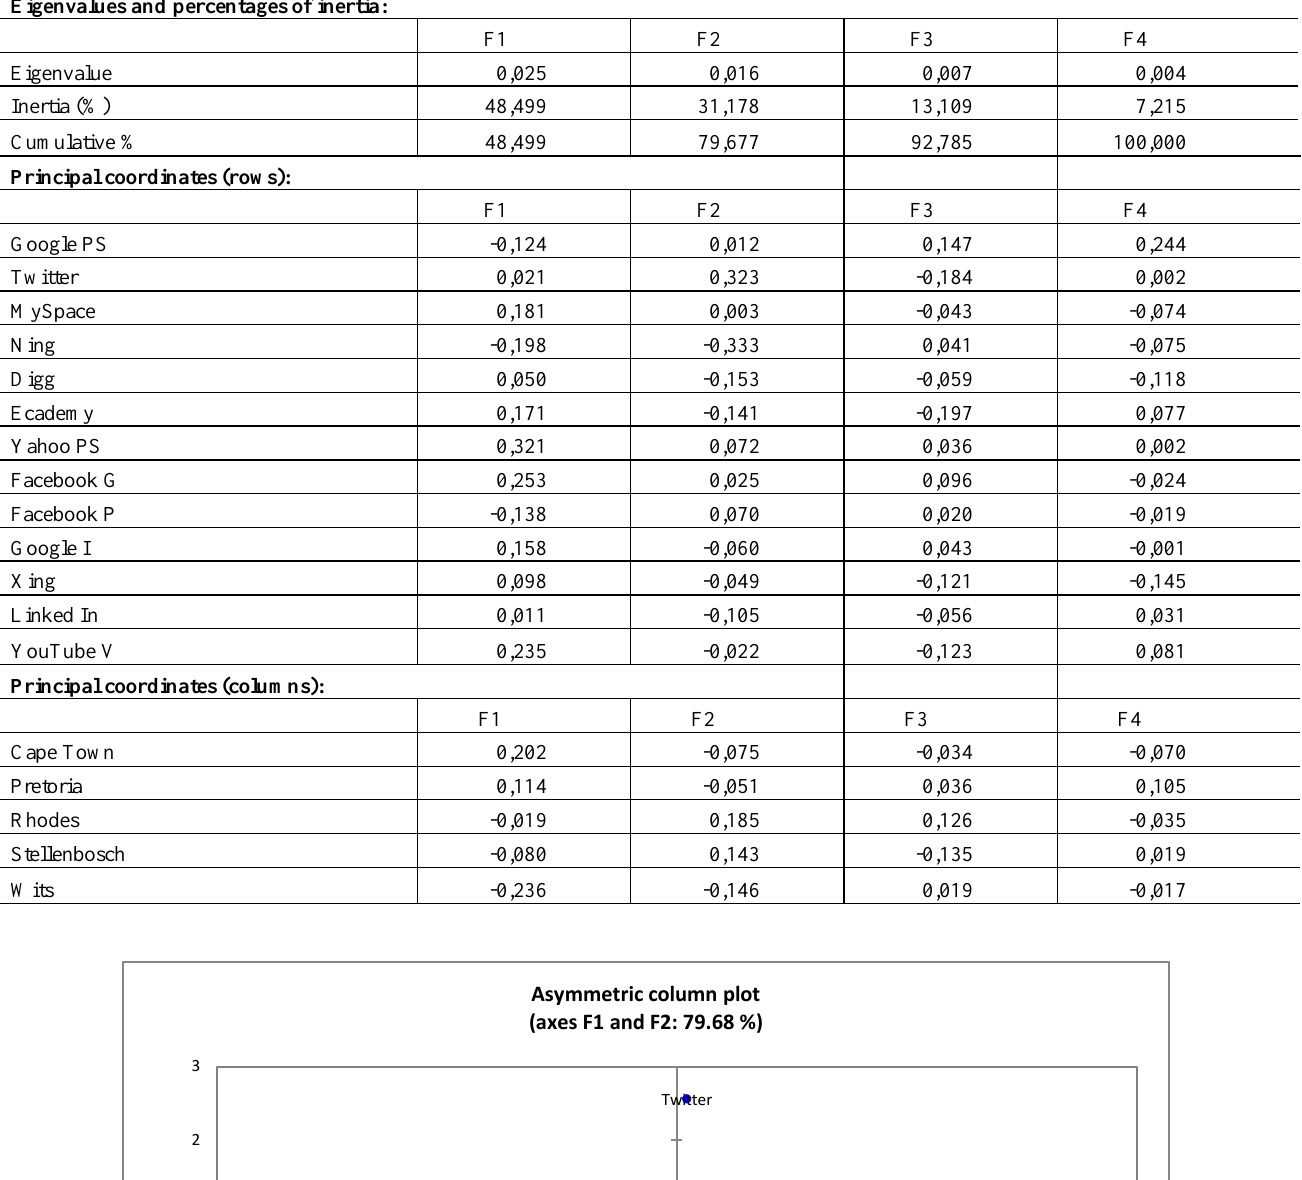
Table 3: Correspondence analysis: Eigenvalues and inertia; principal coordinates of rows and columns Eigenvalues and percentages of inertia: